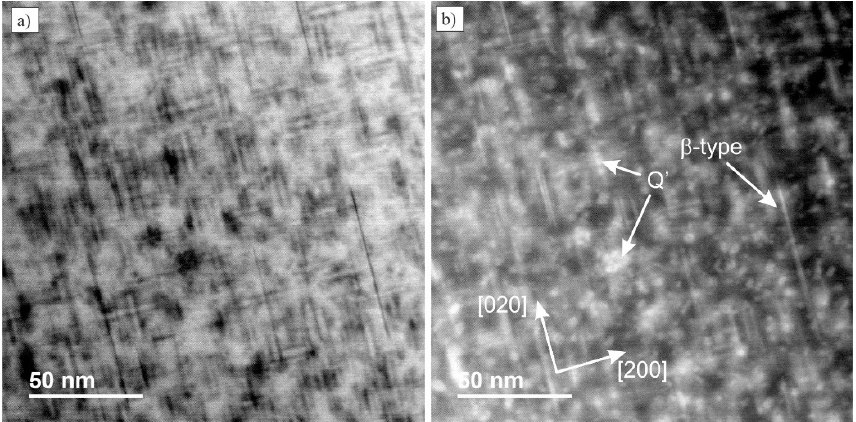
Figure 12. The transmission electron micrographs of the alloy after T6 temper, shoving precipitates. ( a ) Bright-field micrograph and ( b ) HAADF micrograph.